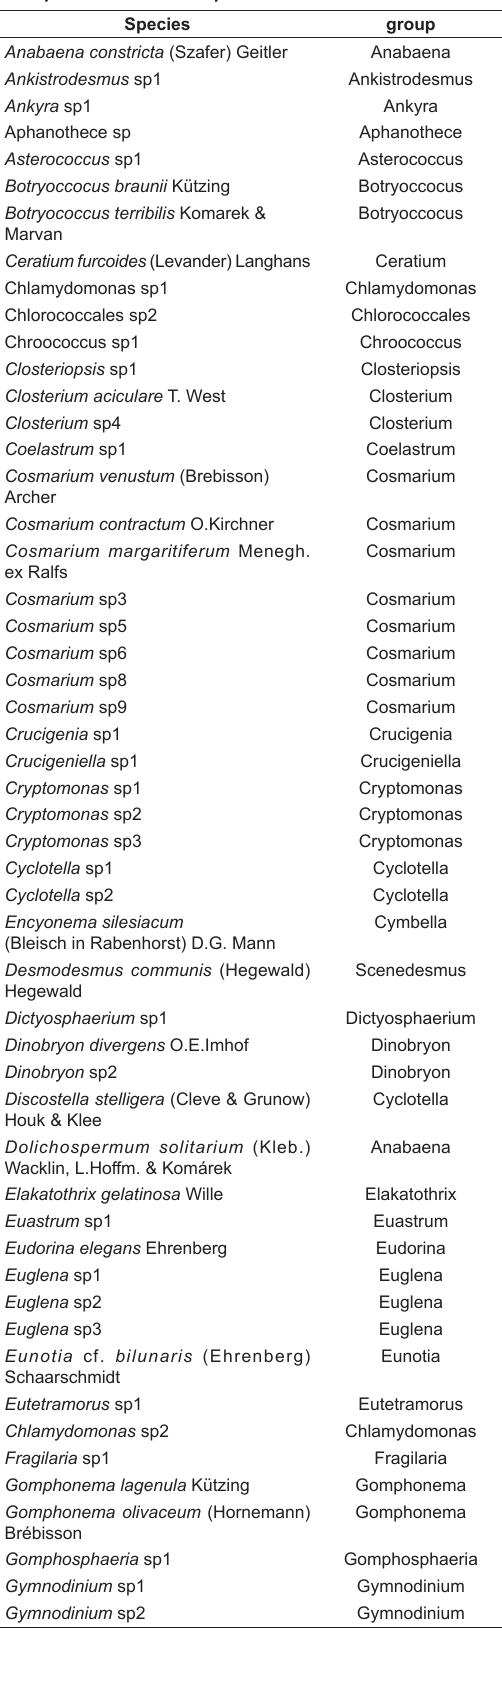
Table 2. Most frequent (>2%) species and groups (genera/ family) used in the